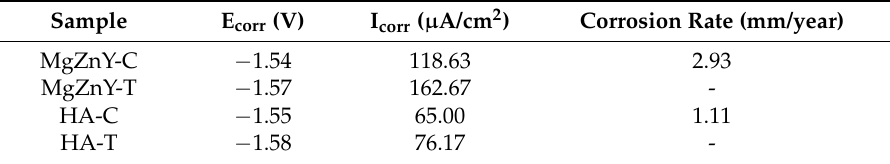
Figure 7. Potentiodynamic polarization curves of MgZnY-C, HA-C, MgZnY-T, and HA-T alloys measured in simulated body fluid (SBF) solution. Table 4. Corrosion potential (E corr ) and corrosion current density (I corr ) measured from the polarization curves, and corrosion rate obtained from the immersion test.